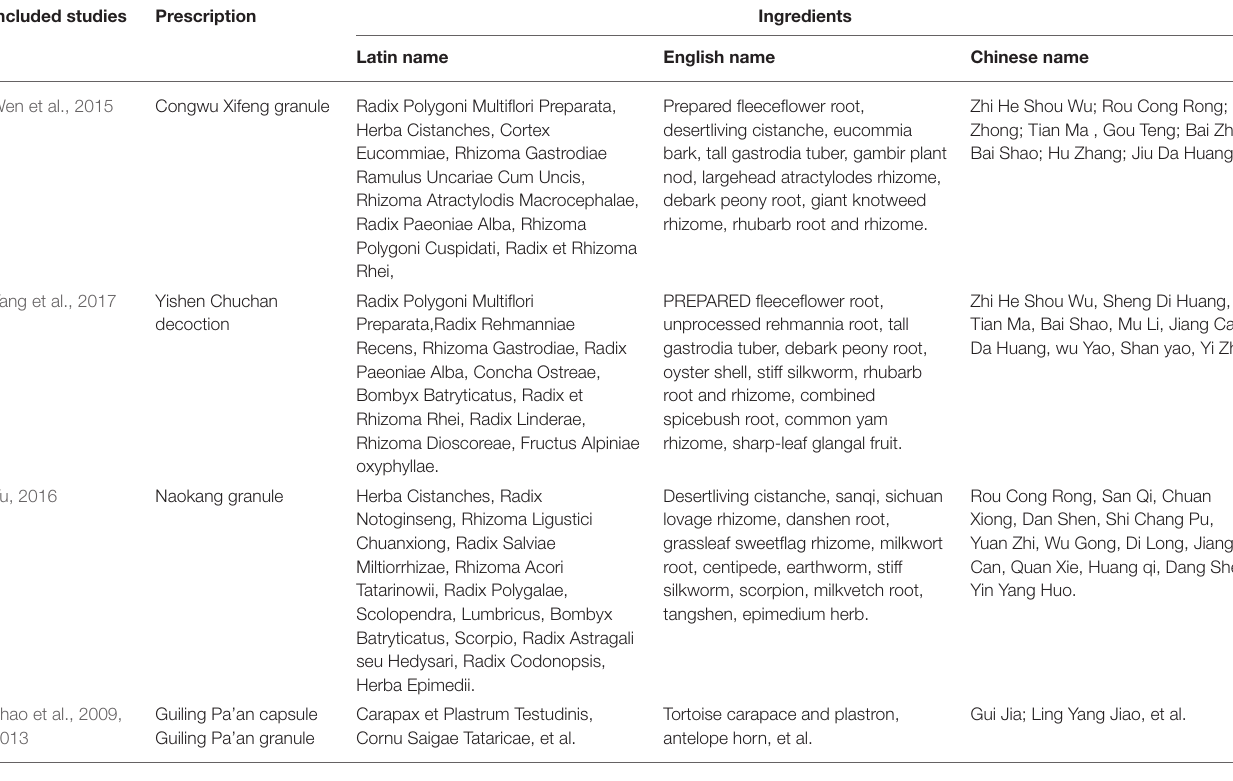
TABLE 3 | The 11 high-frequency used herbs for PD in the 14 trials